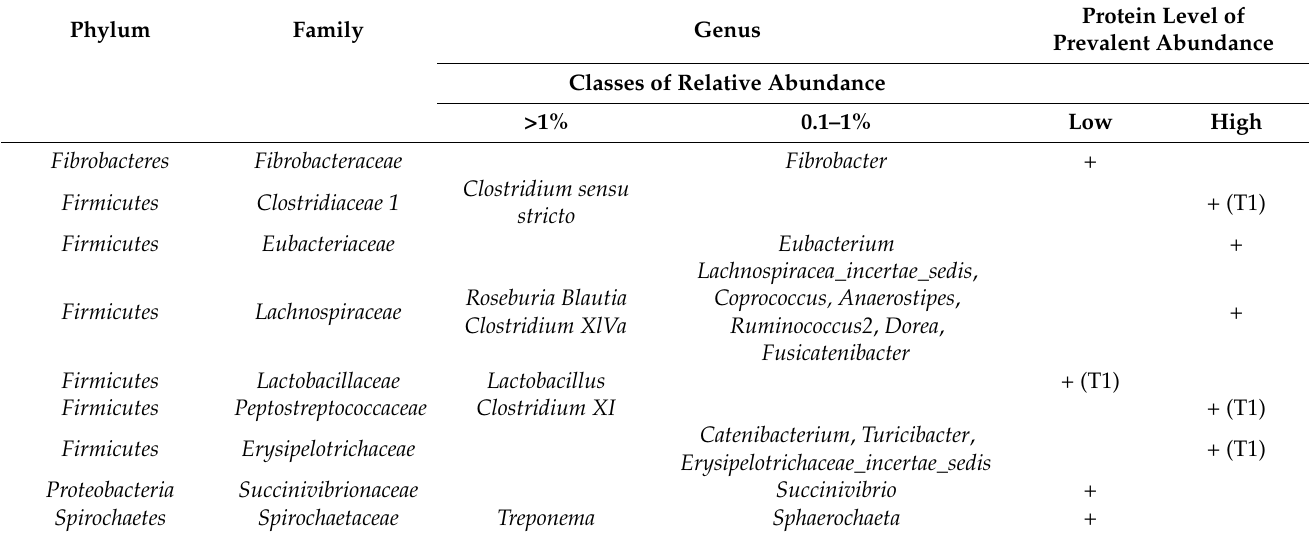
Table 8. Bacterial genera differentially abundant in fecal samples of piglets fed low- or high-protein diets. The notation (T1) indicates that the effect was present only at the sampling time T1.